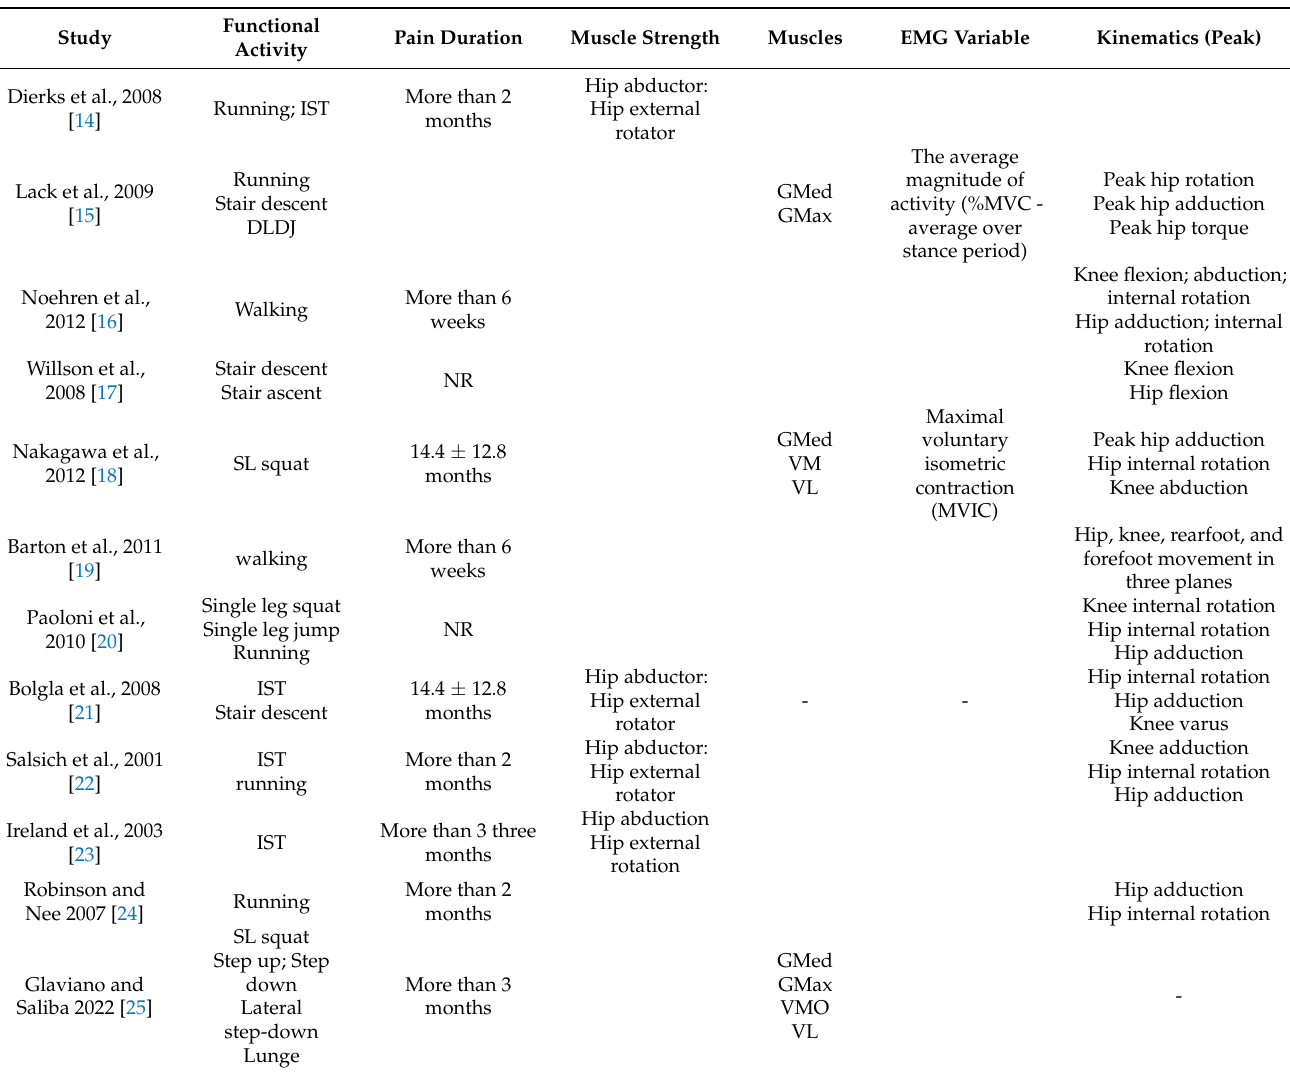
Table 3. Participant activities, muscles, and kinematics variables were evaluated in each included